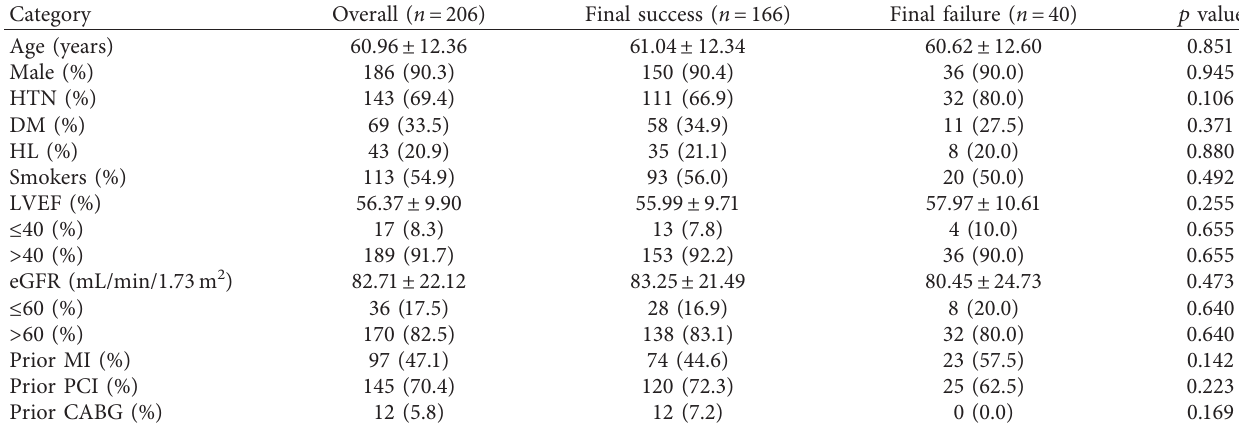
Table 1: Baseline clinical characteristics of the